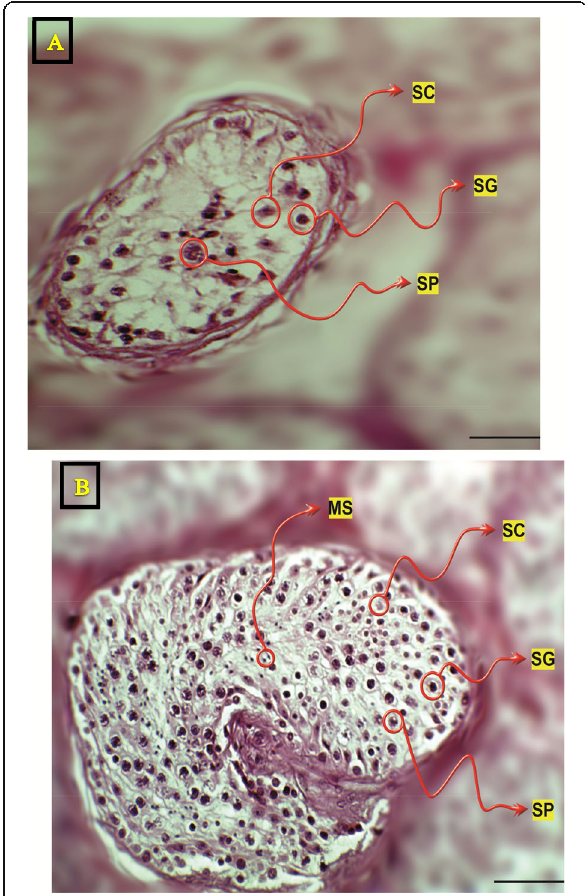
Fig. 2 a Testicular segments of specimens with MA (maturation arrest). b Testicular segments of specimens with HP (hypospermatogenesis). SP = spermatocyte; MS = mature spermatid; SC = Sertoli cell; SG = spermatogonia; Scale bar = 20 μ m